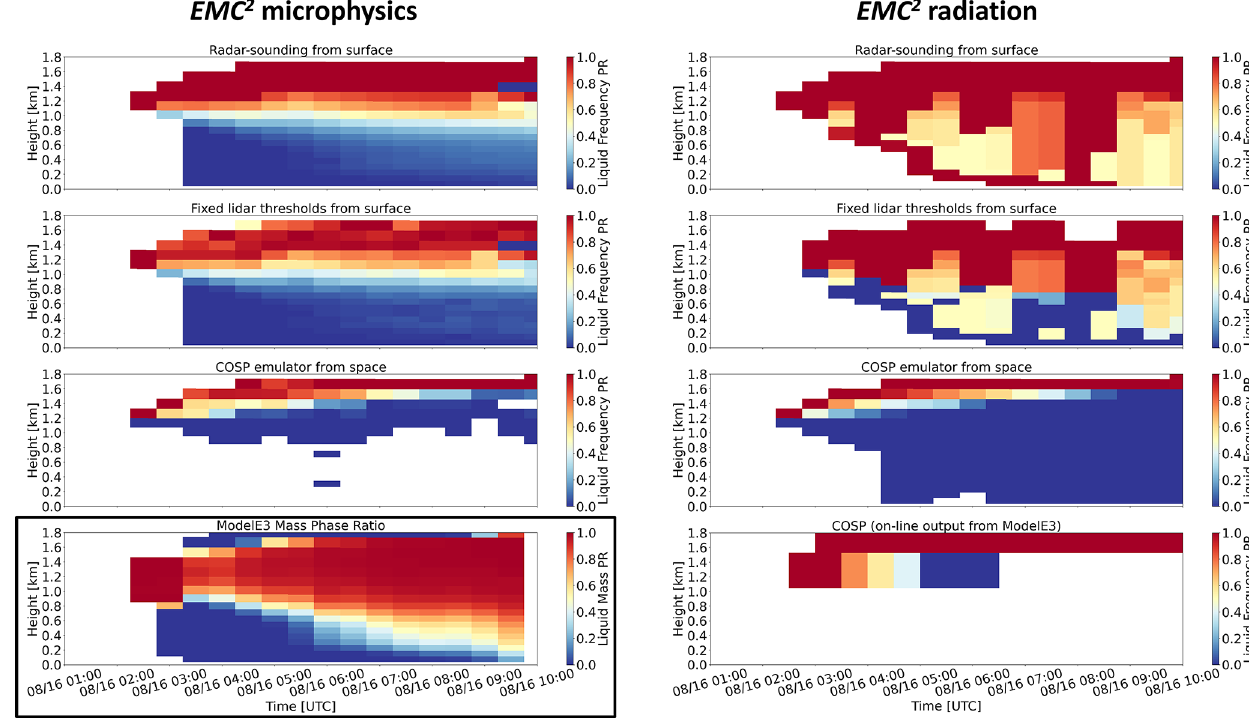
Figure 8. Time–height curtain plots showing the liquid-bearing frequency phase ratio (calculated over all hydrometeor-bearing subcolumn bins) of ModelE3 configuration Tun3 SCM simulation using the microphysics (left) and radiation (right) approaches. The classification methods used to calculate the phase ratios are (from top to bottom) the radar-sounding method, the modified fixed lidar variable threshold method, the COSP lidar simulator emulator (top-down view), and the on-line COSP lidar simulator implemented in ModelE3, which is only processed using ModelE3’s radiation approach. In this figure, the “mixed” class of the radar-sounding method is counted as liquid, while the “undefined” classes in the other two methods are treated as “non-liquid” even though in some cases they are more likely to be liquid- bearing (e.g., the “undefined1” class in the modified fixed lidar variable threshold method). The lower-left panel shows the mass phase ratio calculated using the ModelE3 output without EMC 2